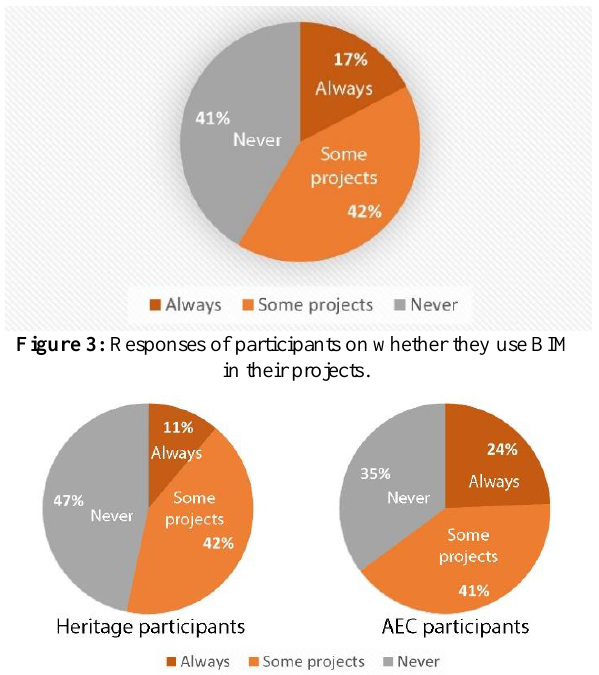
Figure 4: Responses of participants on whether they use BIM in their projects categorised by sector.